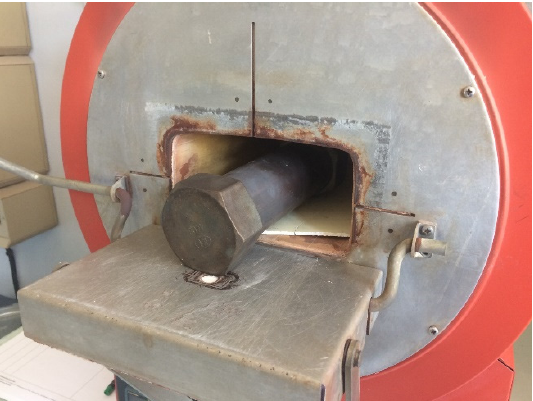
Figure 2 . Small representative component coated with protective layer and filled with molten AlSi 12 .